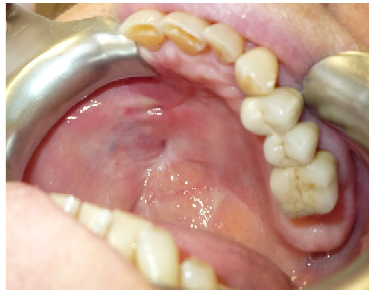
Figure 8. After 2 months.